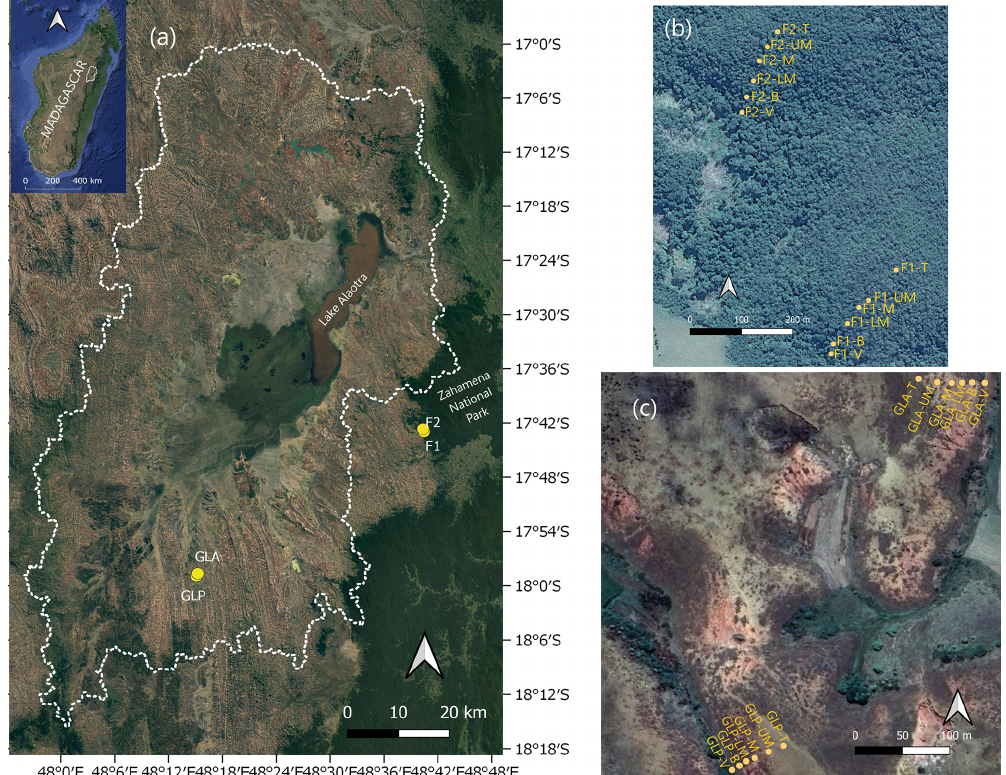
Figure 1. (a) Location of the study region with indication of the sampled hillslope profiles. The dotted white line delineates the watershed of the Lake Alaotra basin. GLA and GLP are the two convex hillslopes under grassland, and F1 and F2 are the two forested convex hillslopes in the Zahamena National Park. Satellite view of the two forest transects (b) and the two grassland transects (c) (© Google Earth